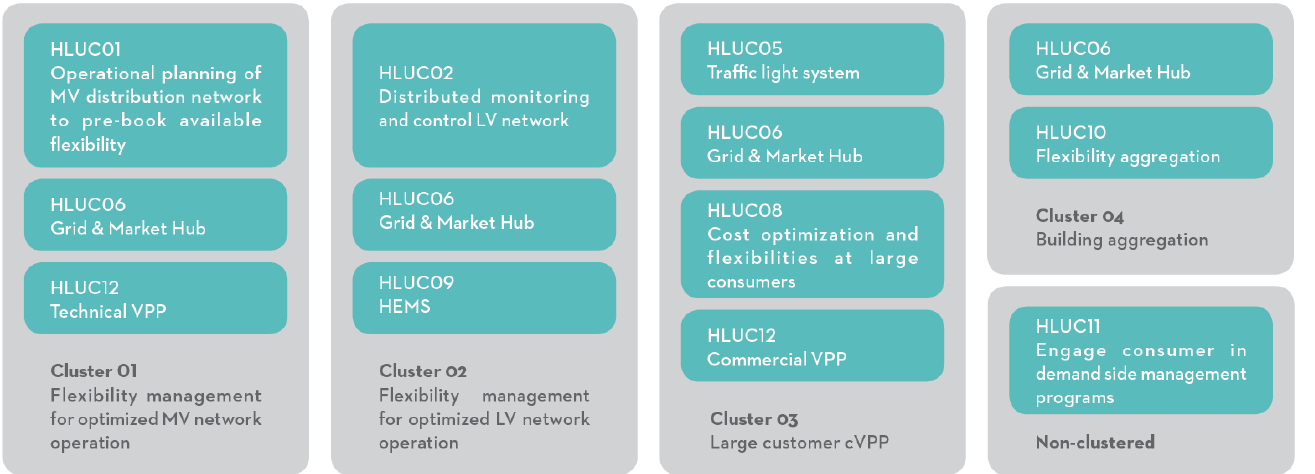
Figure 2. Clusters identified within